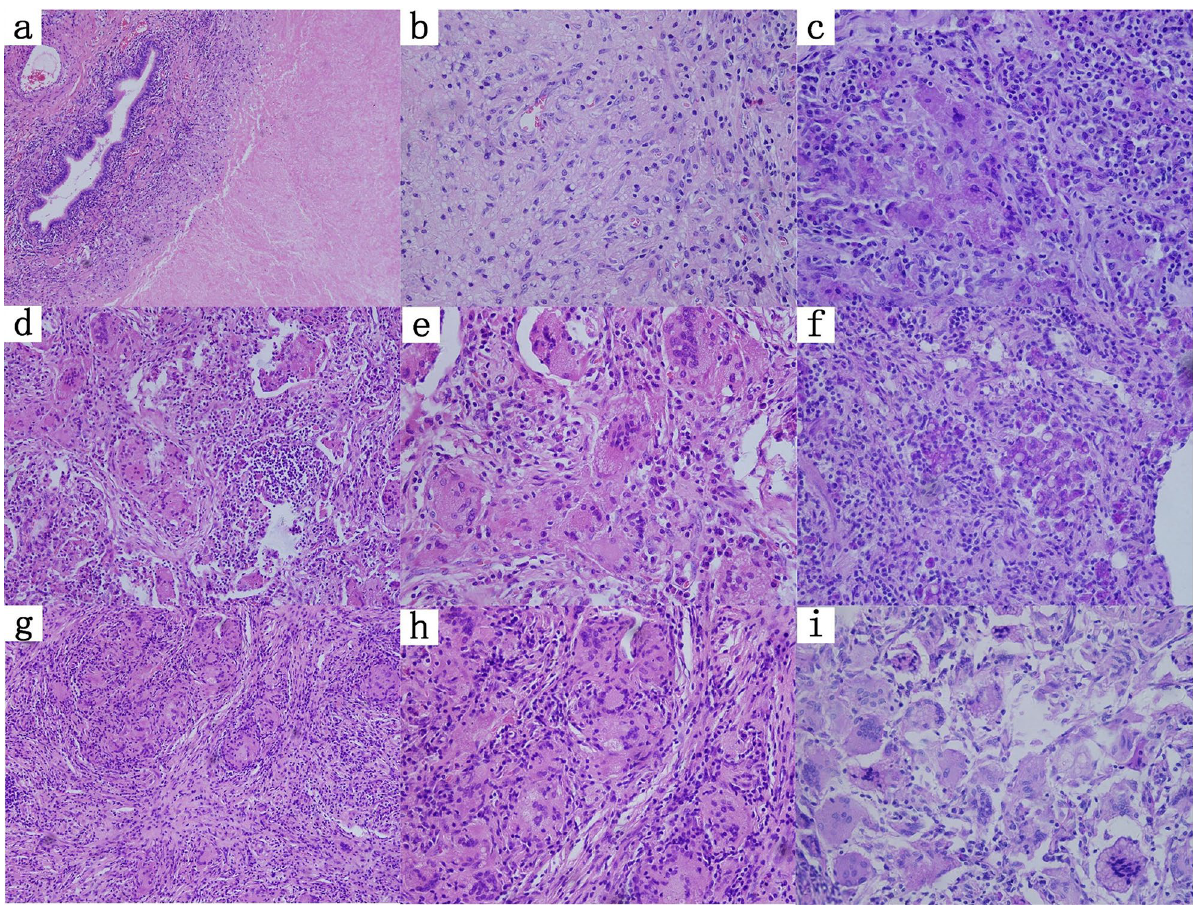
Figure 2. The histopathological characteristics of PC patients. Mucinous mucoid type: ( a HE staining × 20 and b HE staining × 40) mainly consisted of large necrotic and mucinous connective tissue and mass cryptococci without obvious granulomatous lesions. The lung tissue around the lesion showed serous exudative inflammation. ( c PAS staining × 40) A large number of free cryptococcal bodies were found in the alveolar cavity. Inflammatory granulomatous lesions: ( d HE staining × 20 and e HE staining × 40) mainly by a large number of mononuclear macrophages, neutrophils and other inflammatory cells infiltration, inflammatory cells diffuse distribution, the edge of the lesion accompanied by a large number of fibroblast proliferation and inflammatory cell infiltration, ( f PAS staining × 40) a small number of scattered cryptococcal bodies were found in the bronchial wall around the lesion. Nodular fibrogranulomatous lesions: ( g HE staining × 20 and h HE staining × 40) nodular fibrogranuloma lesions were mainly formed by mononuclear macrophages and multinucleated giant cells, with different sizes of multinucleated giant cells. ( i PAS staining × 40) A small amount of Cryptococcus was found in the granuloma.